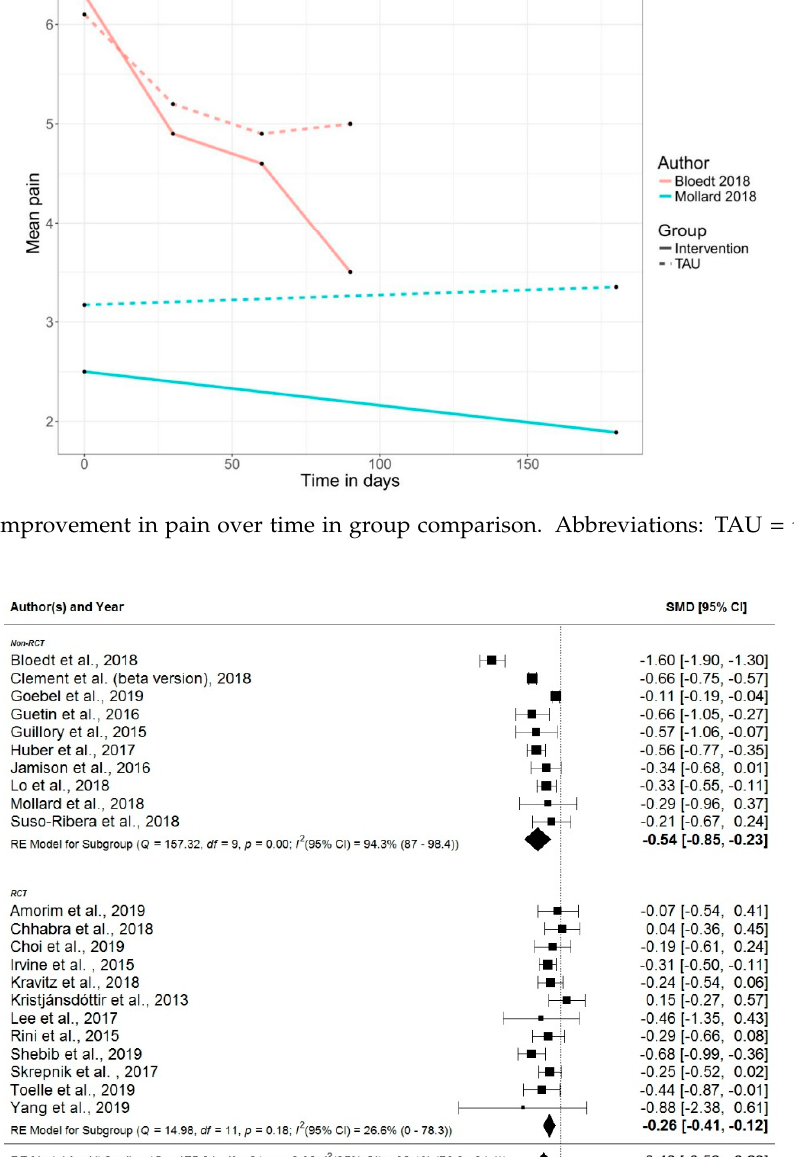
Figure 4. Improvement in pain over time in pre–post studies. Abbreviations: LBP = low back pain; UCP = unspecific chronic pain.